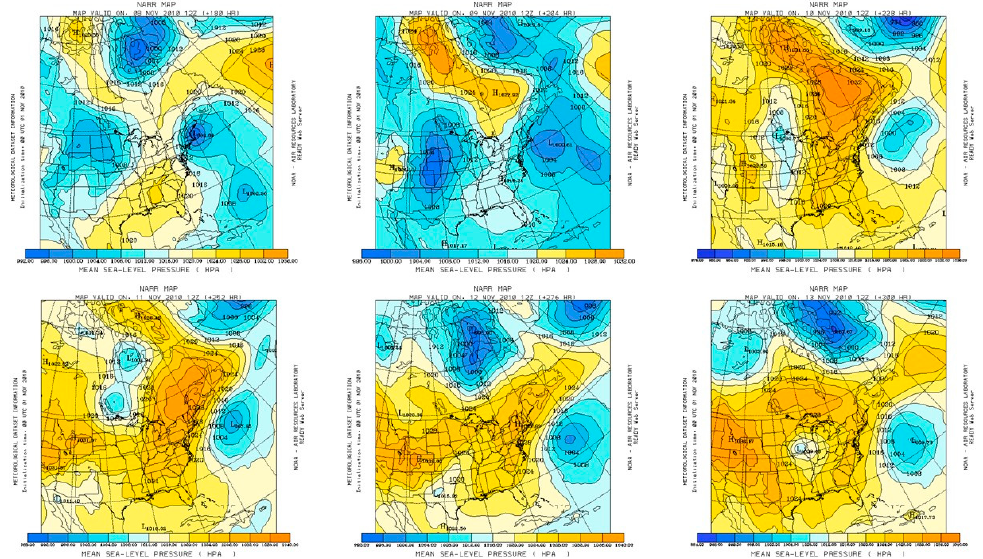
Figure 11. Pattern of MSLP, 8 November (upper left) to 13 November (lower right), 2010. Credit: NOAA ARL.